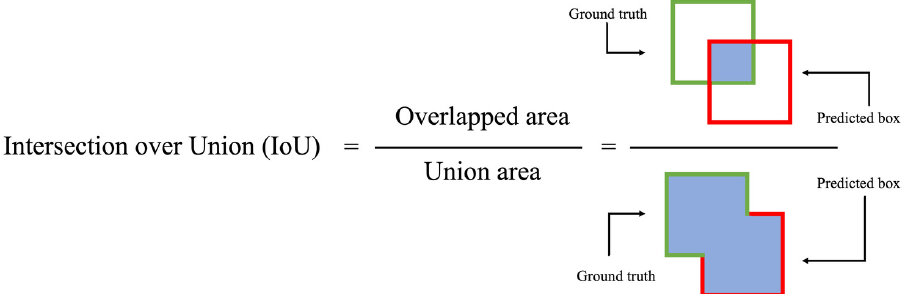
Figure 13. The Intersection Over Union can be calculated by dividing the area of overlap between the bounding boxes by the area of the